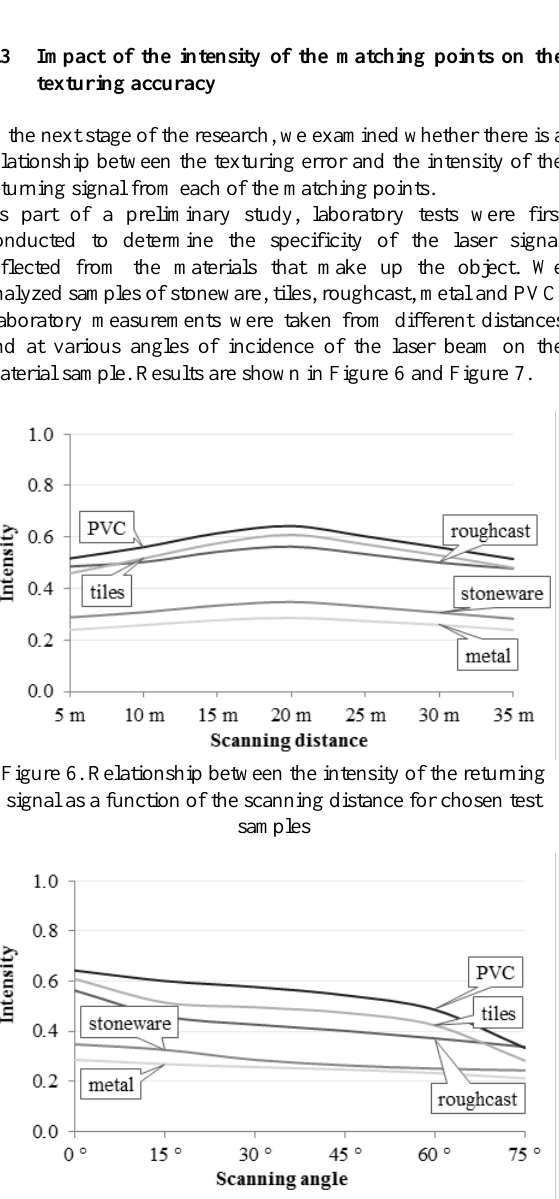
Figure 7. Relationship between the intensity of the returning signal as a function of the scanning angle for chosen test